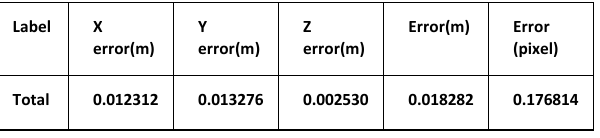
Table 1. Overall spatial accuracy (m) of the UAV derived